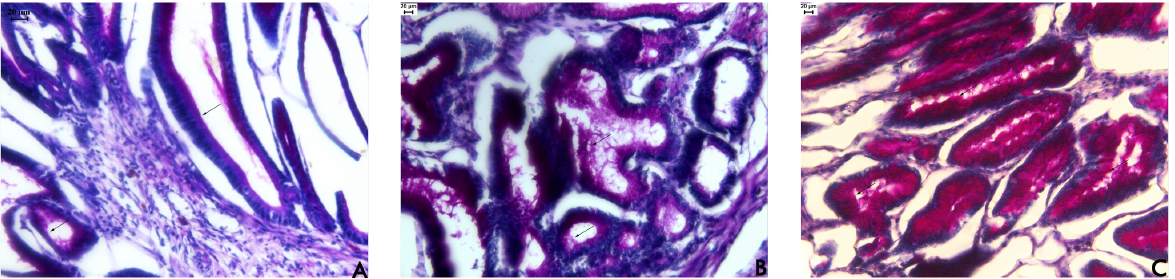
Figure 2. Photomicrography of histological analyses of stomach of rat treated orally with ( A ) vehicle (10 mL/kg); ( B ) cimetidine (100 mg/kg); and ( C ) acetate fraction of Alchornea triplinervia (100 mg/kg). The scale represents 20 µm and arrows denote mucus area by PAS method.